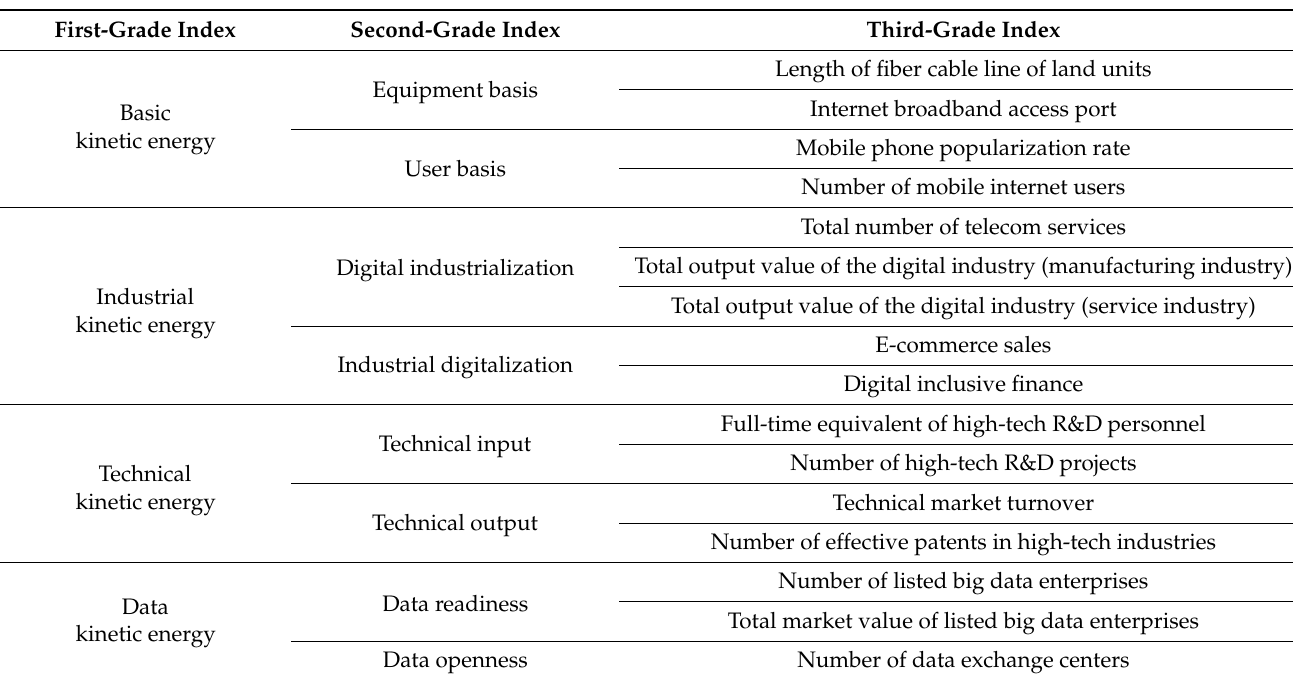
Table 2. Evaluation index system of the digital